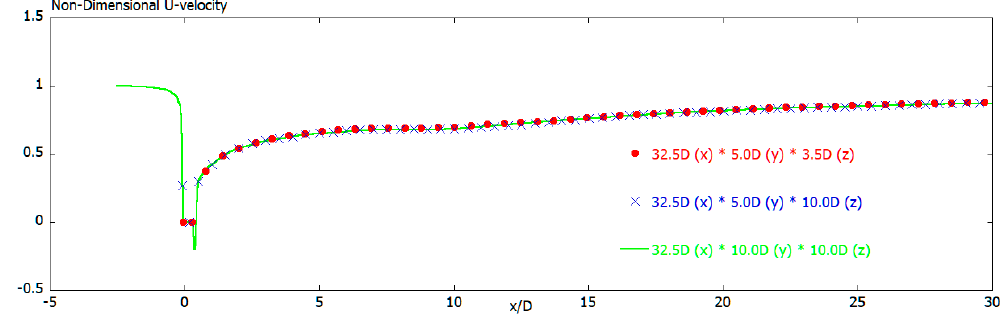
Figure A4. Comparison of time-averaged U-velocity distribution at the hub center of the wind-turbine.